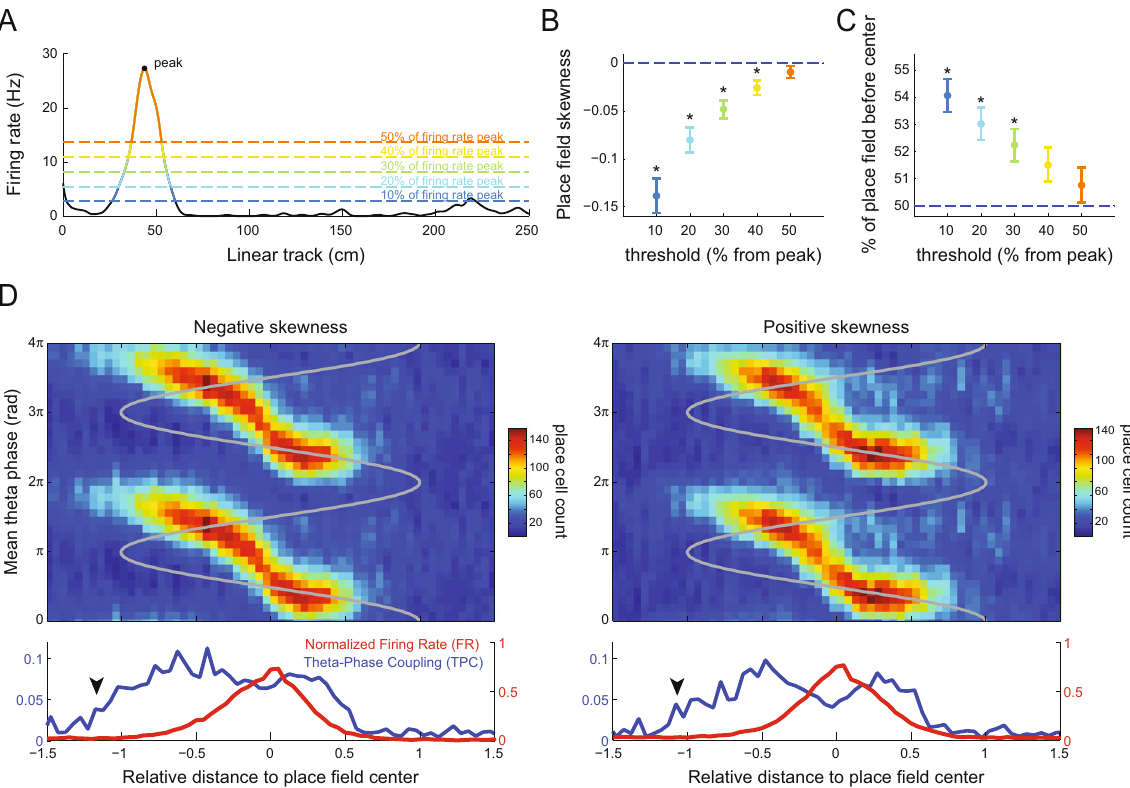
Figure 4. Asymmetric temporal coding irrespective of place field skewness. ( A ) Example place field. Dashed lines show different firing rate thresholds (at 10, 20, 30, 40 and 50% of the peak value) that were used to quantify place field asymmetry. ( B ) Skewness of the firing rate curve at each threshold. ( C ) Percentage of the place field located before the center (position of peak firing rate). In ( B , C ), data points show the mean over individual place fields; errorbars denote standard error of the mean ( * p < 0.01, t-test against 0 or 50% corrected for multiple comparisons). ( D ) Panels show the same as in Fig. 3A,B, but computed using only place cells with negative (left) or positive (right) skewness at the 50%